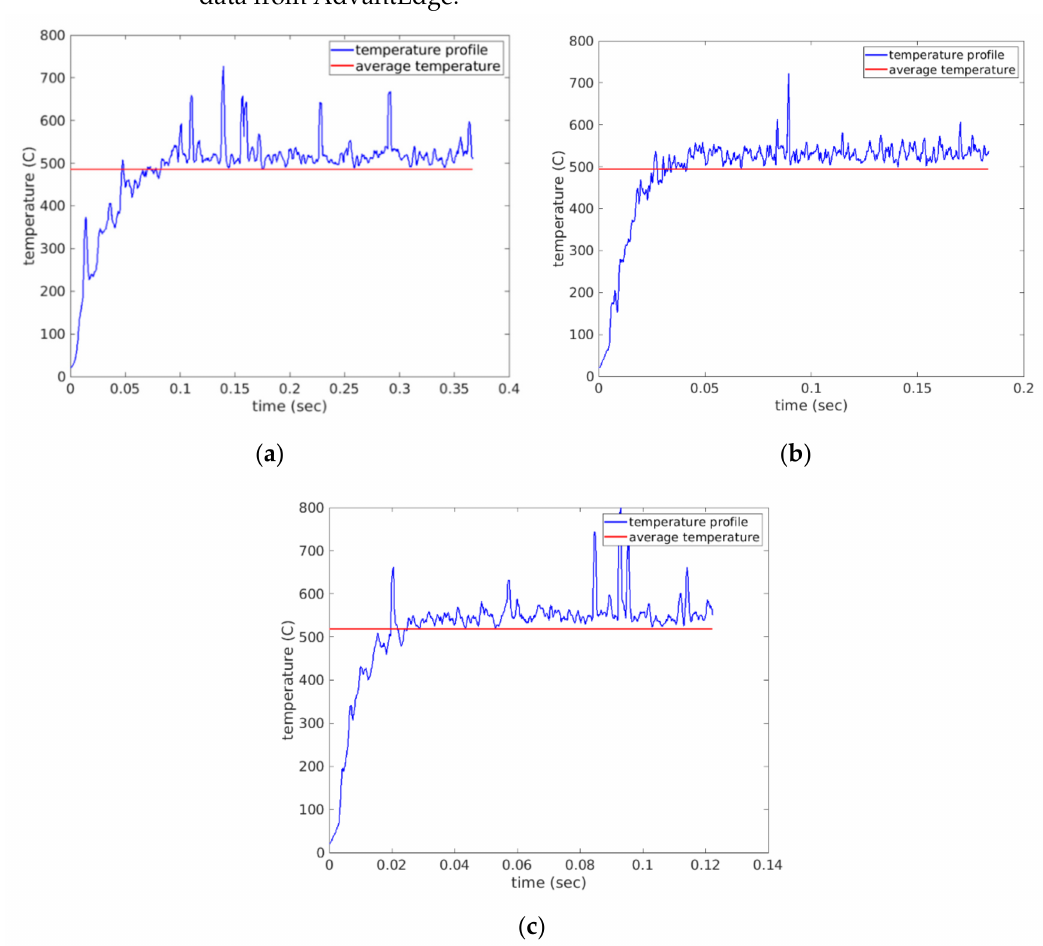
Figure 8. Cutting temperature profiles observed under simulations ( a ) scenario 1 of feed rate 0.75 mm/rev and 1000 spindle rpm ( b ) scenario 2 of feed rate 0.75 mm/rev and 2000 spindle rpm and ( c ) scenario 3 of feed rate 0.75 mm/rev and 3000 spindle